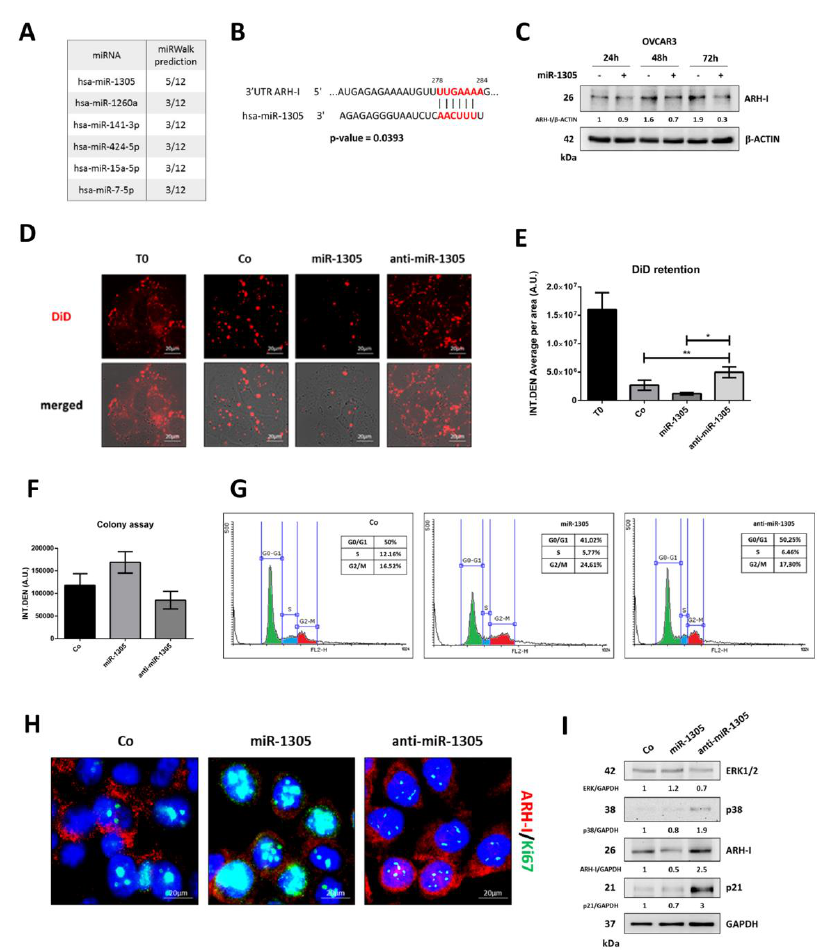
Figure 8. miR-1305 downregulates ARH-I expression, thus sustaining ovarian cancer cell proliferation. ( A ) Table reporting the in silico prediction of miRNA – ARH-I interaction performed by the miRWalk 2.0 software on the six miRNAs previously identified to be oppositely modulated by IL-6 and RV. ( B ) Schematic representation of the interaction between hsa-miR-1305 and the 3′ UTR of ARH-I transcript. The p -value of the predicted interaction is included. ( C ) Time-course Western blot- ting to monitor the effect of miR-1305 mimic on ARH-I protein expression. The densitometric anal- ysis of Western blotting representative of three independent experiments is included. ( D ) Assess- ment of proliferation rate in OVCAR3 cells transfected with miR-1305 mimic or anti-miR-1305 by DiD dye retention after 72 h. Scale bar = 20 µm; magnification = 63×. ( E ) Graph reporting the quan- tification of DiD dye retention. Significance was considered as follows: ** p < 0.01; * p < 0.05. ( F ) Graph representing the colony formation assay performed after 72 h of transfection. Data ± S.D. are representative of three independent replicates. ( G ) Cell cycle analysis performed on day 5 and day 10. Cells were fixed, stained with propidium iodide, and acquired by using a FacScan flow cytome- ter. ( H ) Immunofluorescence double-staining for ARH-I (red) – Ki-67 (green) in OVCAR3 cells trans- fected with miR-1305 or anti-miR-1305 for 72 h. Scale bar = 20 µm; magnification = 63×. ( I ) Western blotting analysis for the expression levels of proliferation (ERK1/2) and quiescence markers (p38, ARH-I, p21) in cells transfected with miR-1305 or anti-miR-1305 for 72 h. The densitometric analysis of Western blotting representative of three independent experiments is included.